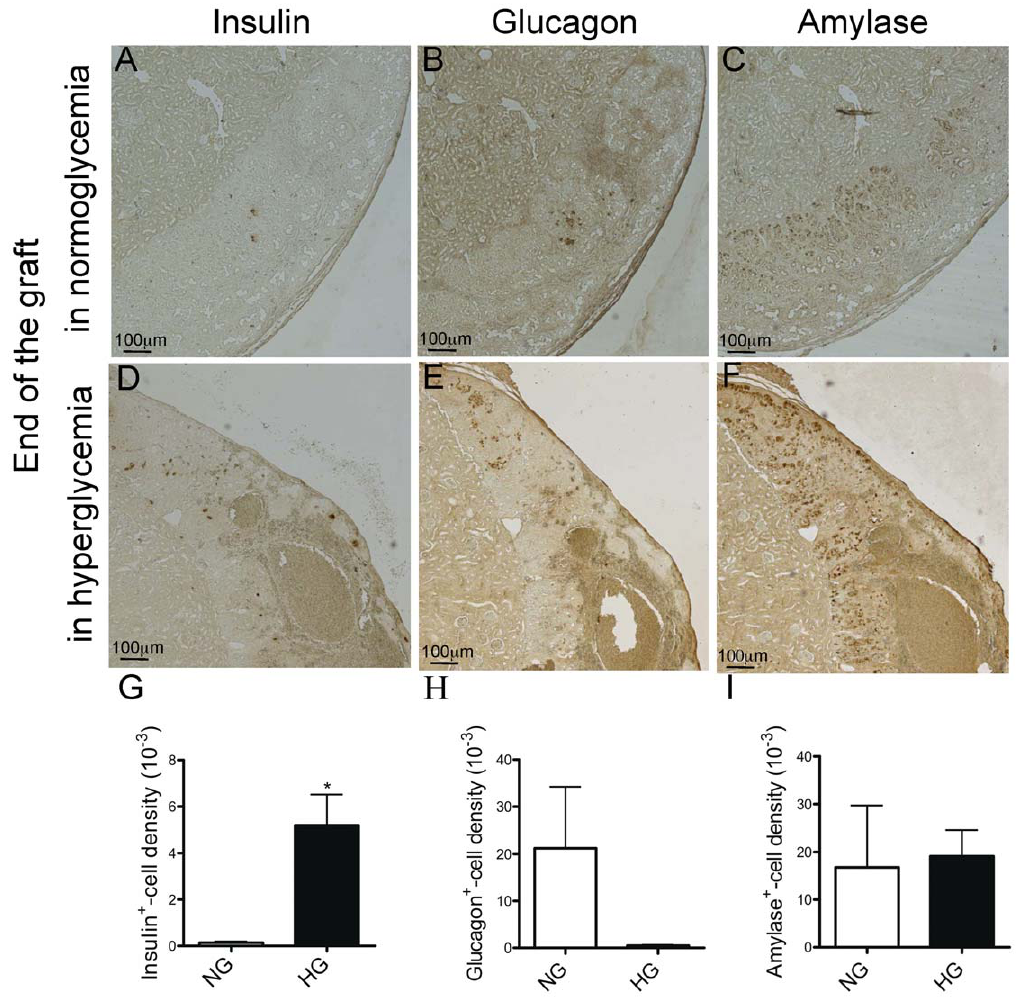
Figure 3. Endocrine and exocrine differentiation in normo and hyperglycaemic pancreas. Insulin (A, D), glucagon (B, E) and amylase (C, F) positive-cells in 2 weeks grafted pancreata in normoglycaemic (A–C) and hyperglycaemic conditions (D–F). Quantification of insulin (G), glucagon (H) and amylase (I) positive-cells density. Hyperglycaemia increased beta-cell density (G). Student t- test *p , 0.05, n=3–5.